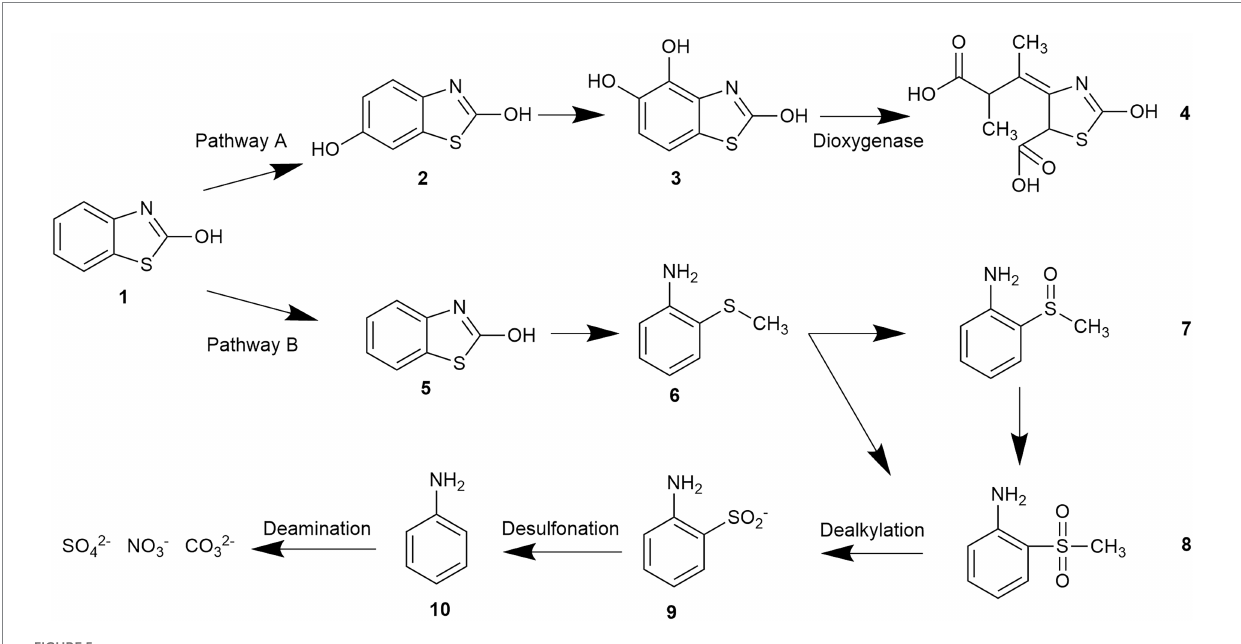
FIGURE 5 Two degradation pathway of